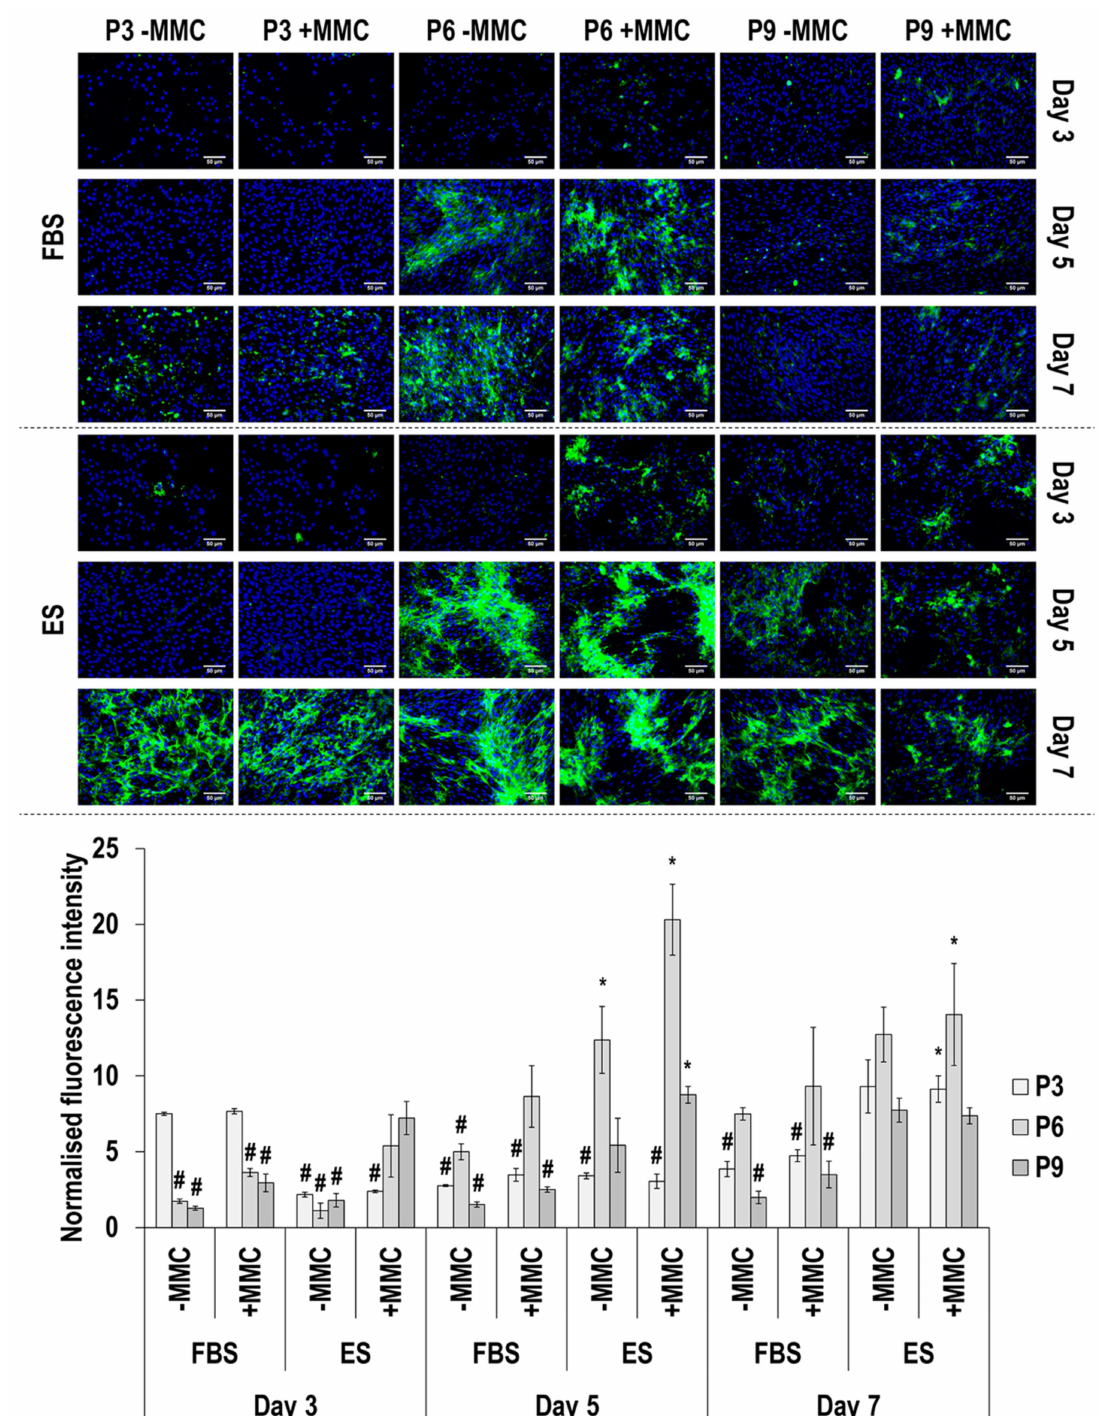
Figure 4. Immunofluorescence and image intensity analysis for collagen type IV as a function of serum, passage, MMC and time in culture. Fluorescence intensity was normalised to cell number. * indicates significant ( p < 0.05) increase in comparison to cells at passage 3, day 3, in FBS and without MMC. # indicates a significant ( p < 0.05) decrease in comparison to cells at passage 3, day 3, in FBS and without MMC. Scale bar: 50 µ